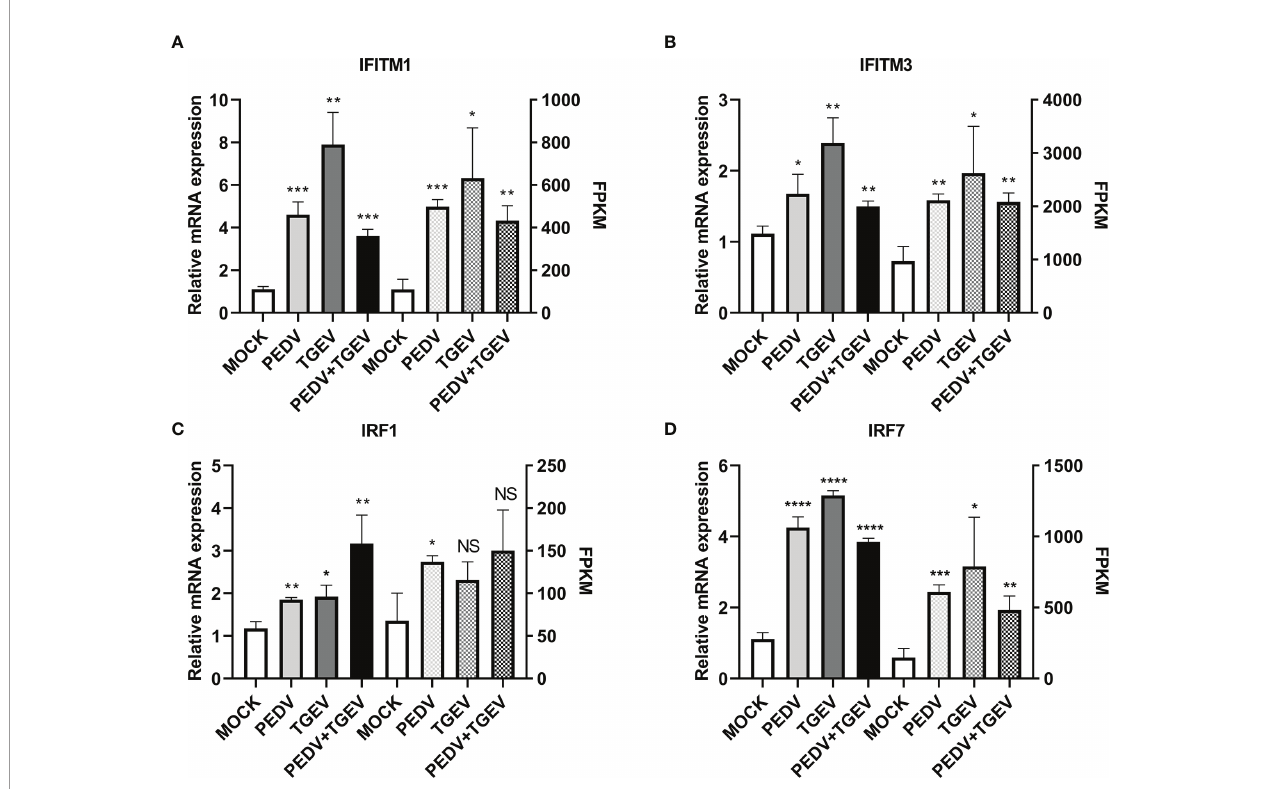
FIGURE 6 | Differentially expressed key genes. IPEC-J2 cells were infected with 1 MOI of PEDV, TGEV, and PEDV+TGEV for 24 hpi. The expression levels of IFITM1 (A) , IFITM3 (B) , IRF1 (C) , and IRF7 (D) were compared at 24 hpi with RT-PCR. GAPDH was used as the internal control. *, p-value <0.05; **, p-value <0.01; ***, p- value <0.001; ****, p-value <0.0001. NS, no signi fi